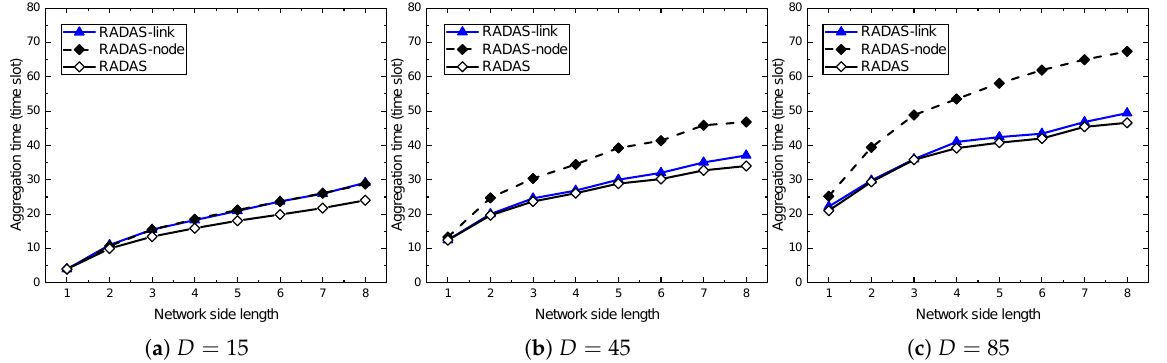
Figure 7. The impact of network side length on proposed schemes.